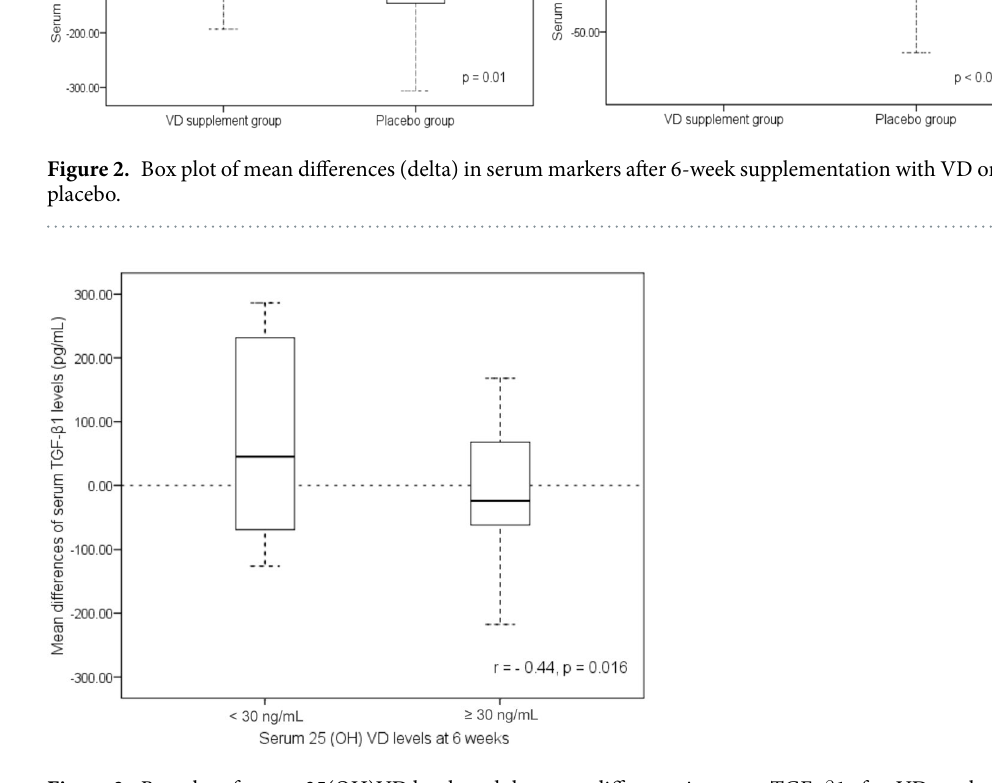
Figure 3. Box plot of serum 25(OH)VD levels and the mean difference in serum TGF- β 1 after VD or placebo supplementation for 6